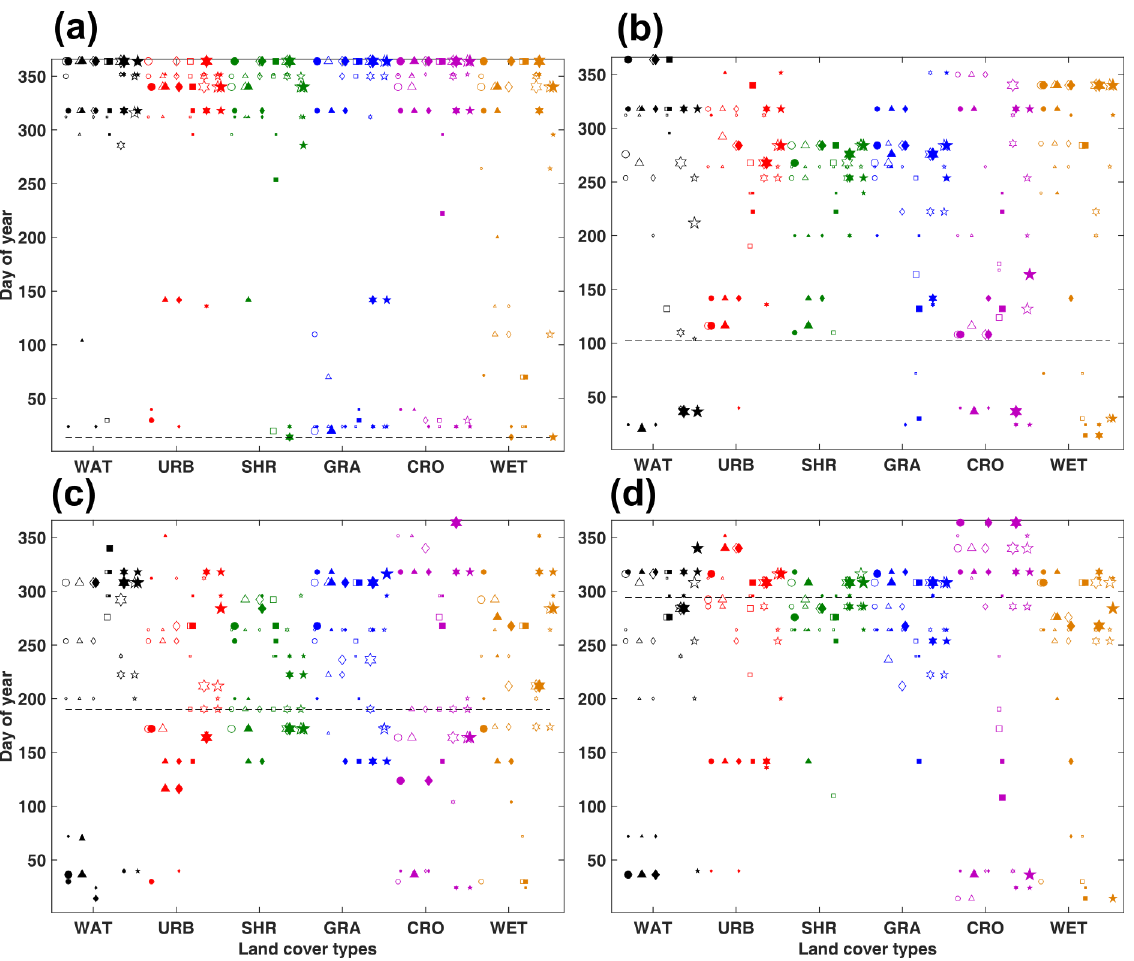
Figure 5. Distribution of the day of year (DOY) for maximum R 2 (not filled marker) and minimum RMSE (filled marker) value for year 2001, 2003 and 2008. The corresponding simulation date (dash line) is ( a ) 14 January (DOY: 14), ( b ) 12 April (DOY: 102), ( c ) 9 July (DOY: 190) and ( d ) 21 October (DOY: 294) for year 2009, respectively. The size of marker from small to big denotes years 2001, 2003 and 2008, respectively. The markers for six Landsat-like bands are circle, triangle, diamond, square, hexagram and pentagram, respectively. The color for each land cover type is black (WAT: water), red (URB: urban), green (SHR: shrub), blue (GRA, grassland), violet (CRO: cropland) and brown (WET: wetland). The meaning of marker and color for symbols is the same for Figure